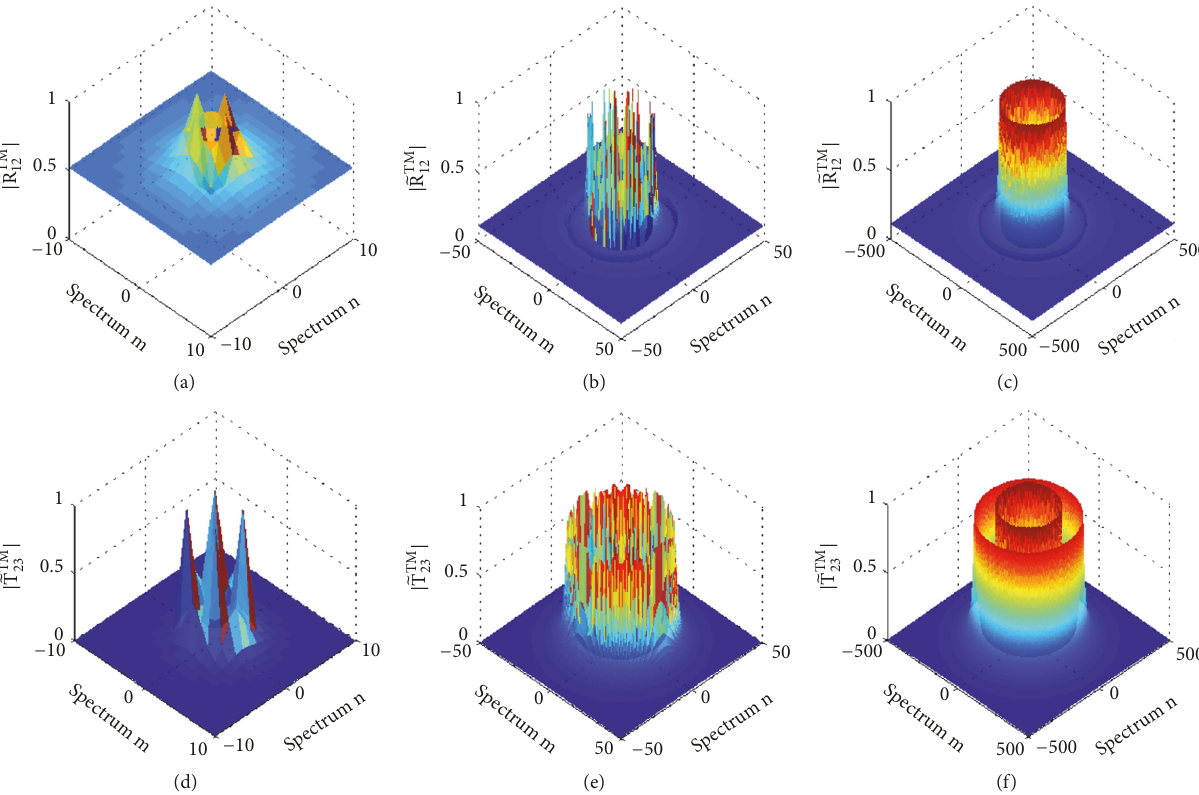
|̃𝑅 𝑇𝑀 | for (a) Δ 12